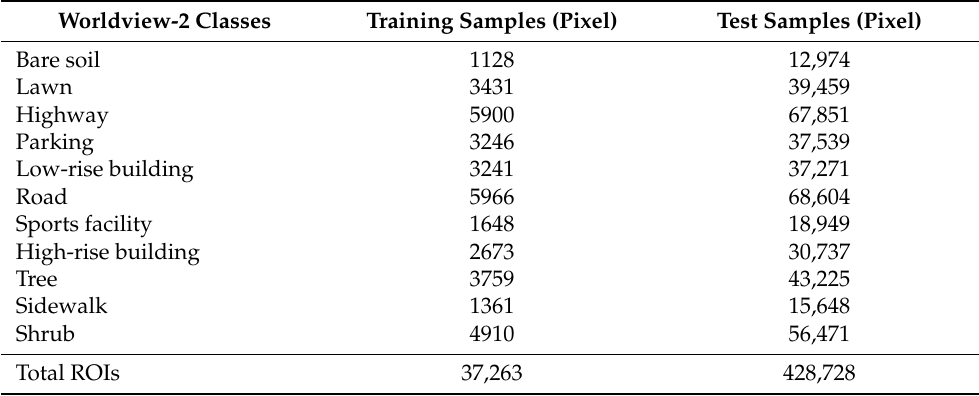
Table A2. Training and test samples for each class in the Tehran